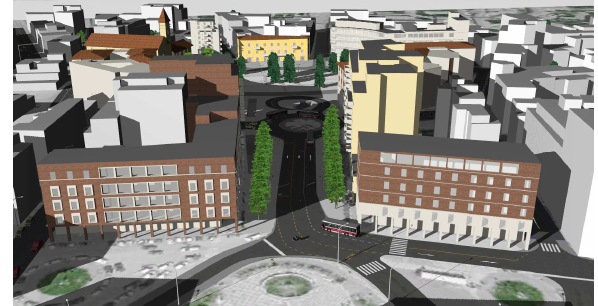
Figure 2. Different treatment of the surfaces of the buildings Therefore, in the third step specific textures on some specific buildings have been put, in order to visualize some important difference between the function of the buildings..